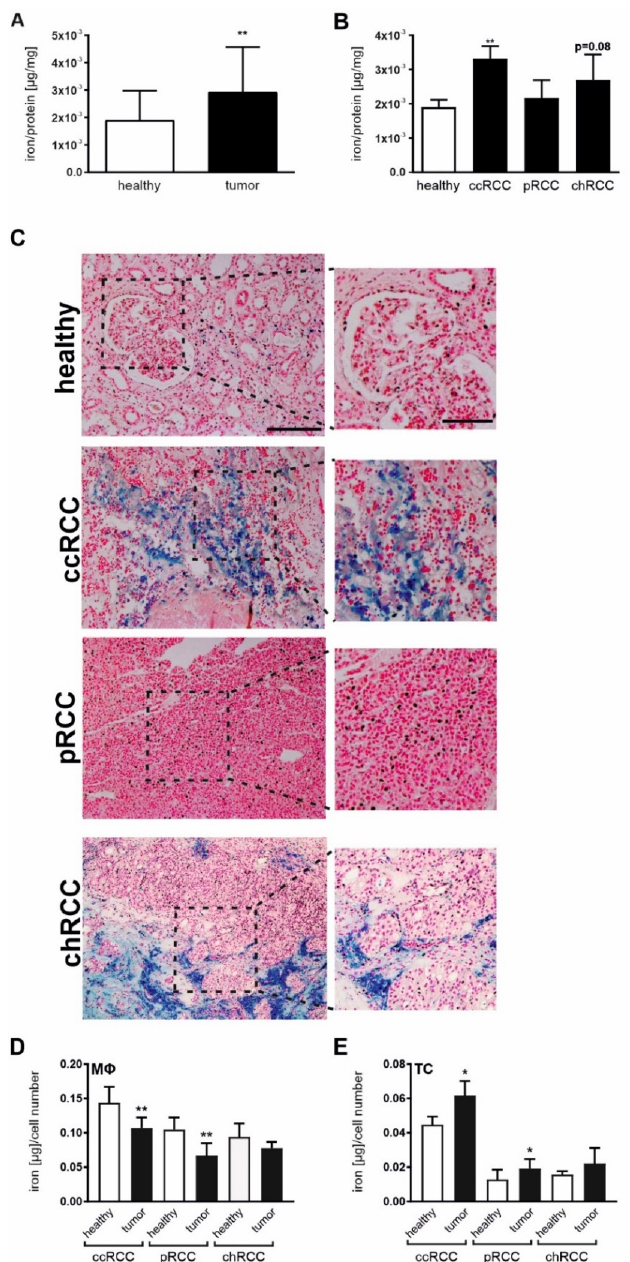
Figure 3. Iron homeostasis and distribution is altered in RCC. ( A ) Iron load normalized to protein amount in whole tissue homogenates of renal cancer tissue in comparison to adjacent healthy renal tissue measured by AAS ( n = 31). ( B ) Iron load in whole tissue homogenates of clear cell (ccRCC; n = 17), papillary (pRCC; n = 7), and chromophobe (chRCC; n = 7) RCC in comparison to corresponding healthy renal tissue measured by AAS. ( C ) Representative pictures of Perl’s staining of RCC tissue and adjacent healthy renal tissue of ccRCC, pRCC, and chRCC. Representative pictures (scale bar: 200 µm) with corresponding detailed pictures (scale bar: 100 µm) are given. ( D,E ) Macrophages (M Φ ) and CD326+ cells were isolated by FACS-sorting from RCC tissue and adjacent healthy tissue. Intracellular iron load of ( D ) M Φ and ( E ) either tumor cells (TC) or epithelial cells from adjacent healthy tissue of ccRCC ( n = 7), pRCC ( n = 13), and chRCC ( n = 4) measured by AAS. Statistical analysis was performed comparing tumor to adjacent healthy tissue within the histopathological subtypes. Graphs are displayed as means ± SEM. * p < 0.05, ** p < 0.01.